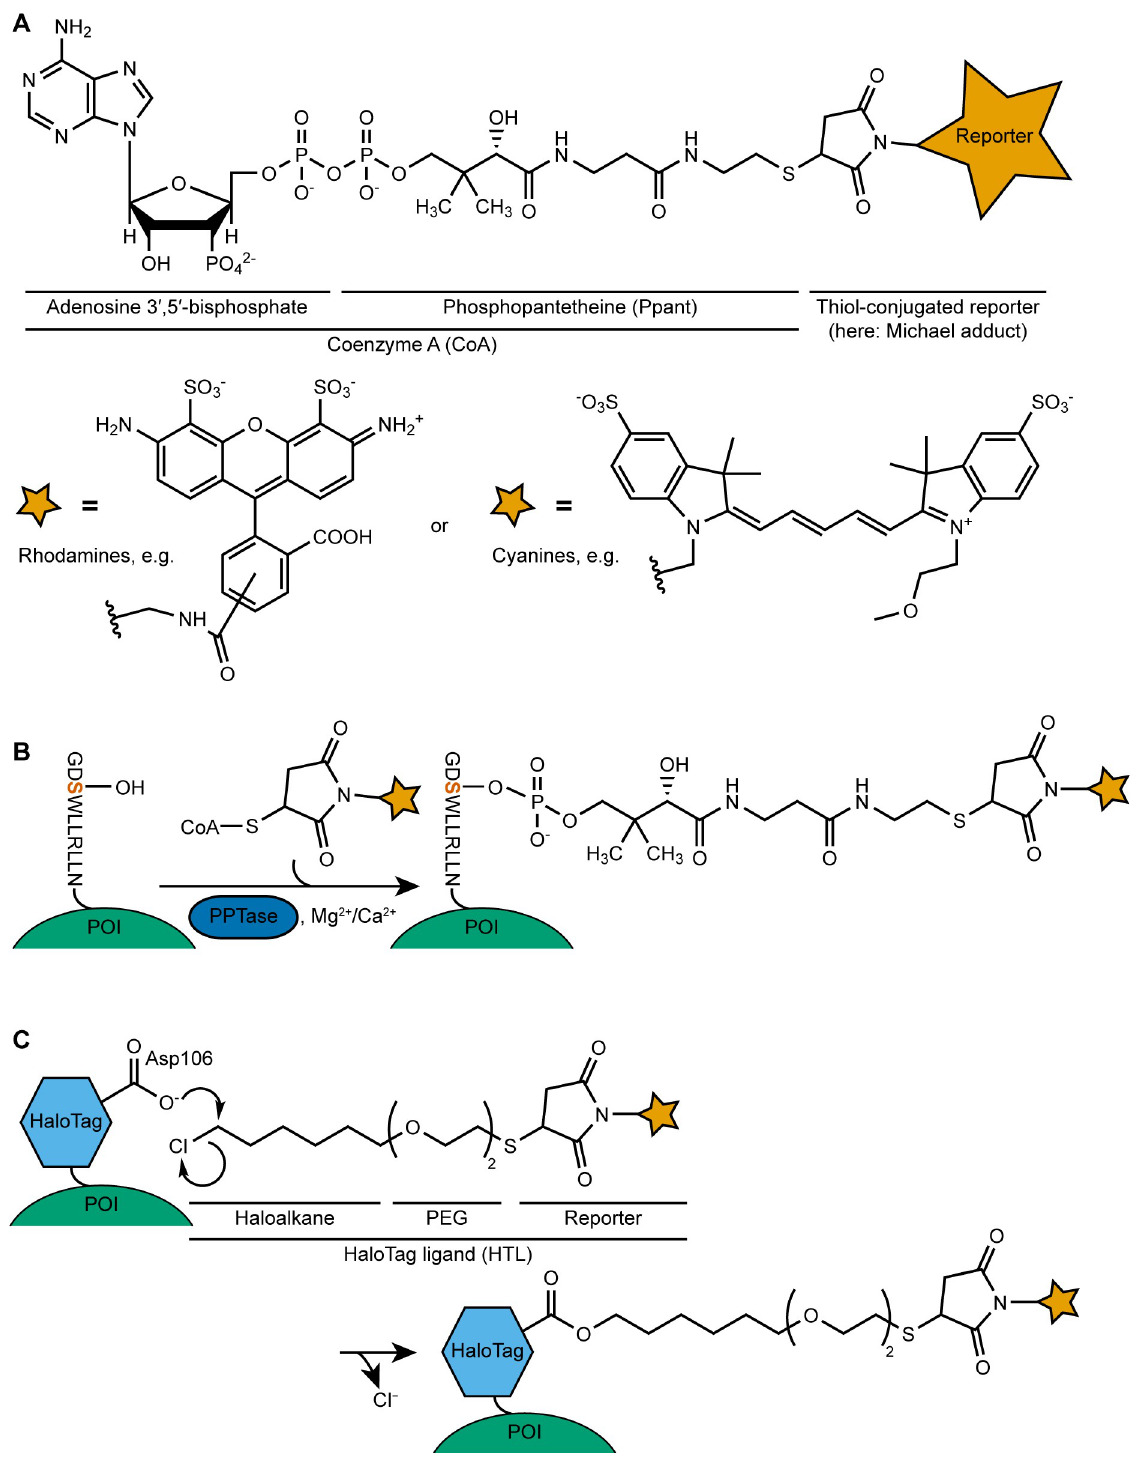
Fig 1. Live-cell labeling strategies described in this work. (A) Structure of a CoA-reporter conjugate [7], and examples of possible reporter dyes, easily attachable through maleimide chemistry to the thiol group of CoA. (B) Labeling of small peptide tags, genetically fused to the protein of interest (POI), mediated through 4 0 -phosphopantetheinyl transferase (PPTase) enzymes. (C) A HaloTag ligand (HTL), comprising a chloroalkane, polyethylene glycol (PEG) linker units for better access to the catalytic center of the enzyme as well as for improved solubility [8], and a reporter, in this example again coupled via thiol chemistry as in (A).The HaloTag, which can be genetically fused to the protein of interest, is a haloalkane dehalogenase engineered to stably form a reaction intermediate, allowing covalent incorporation of labeled substrates.